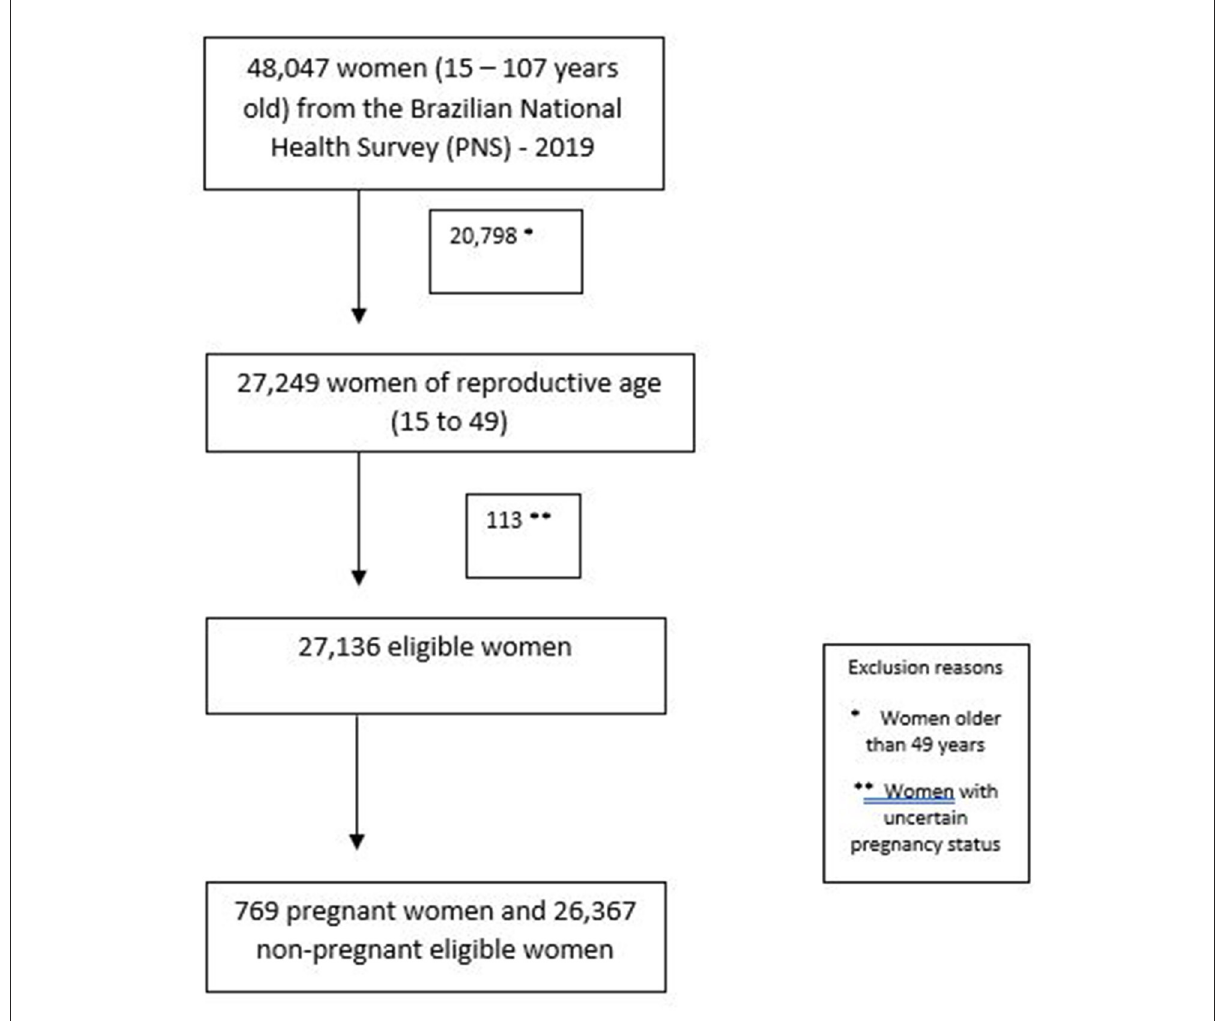
FIGURE1 Participants flowchart. * Women older than 49 years. ** Women with uncertain pregnancy status.